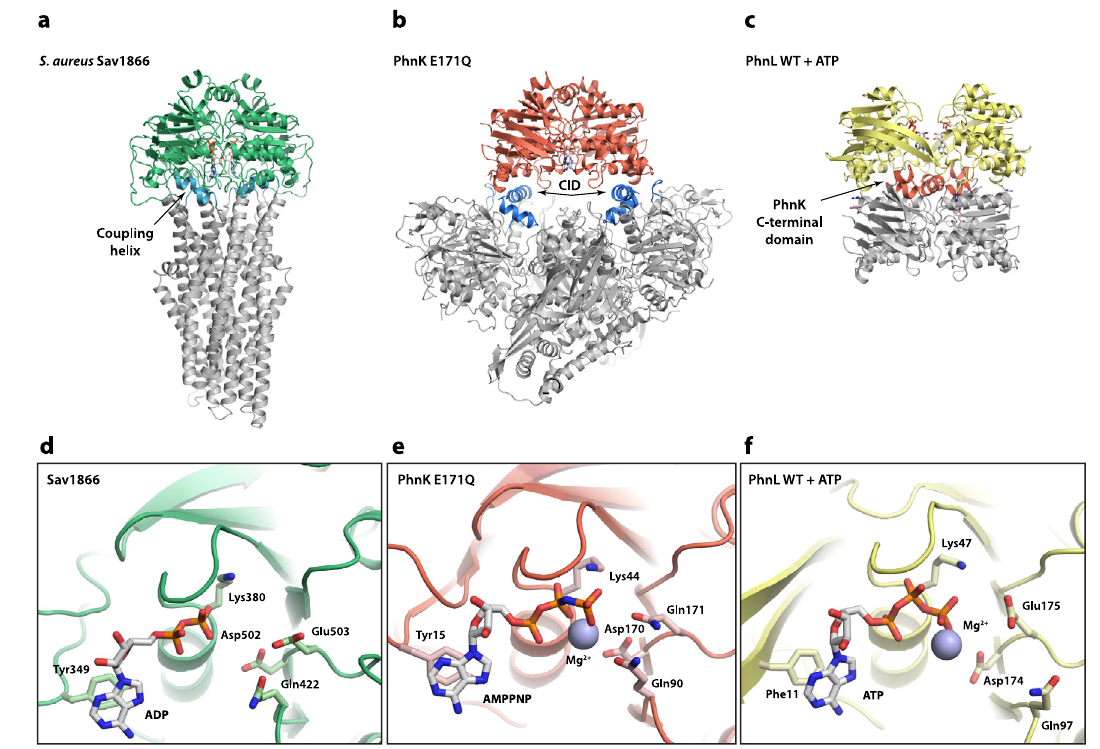
Fig.5|ComparisontotheABCtransporters.a Overviewofthestructureofthe S. aureus Sav1866 ABC transporter in the ADP-bound conformation with the ABC moduleingreenandtransmembranedomainingrey,exceptforthecouplinghelix, responsible for the interaction between the two, which is shown in cyan (2HYD) 24 b Overview of the structure of the C-P lyase core complex with a dimer of PhnK E171QintheATPboundconformationwiththePhnKdimerinredandtheC-Plyase core complex in grey except for the PhnJ Central Insertion Domain (CID),